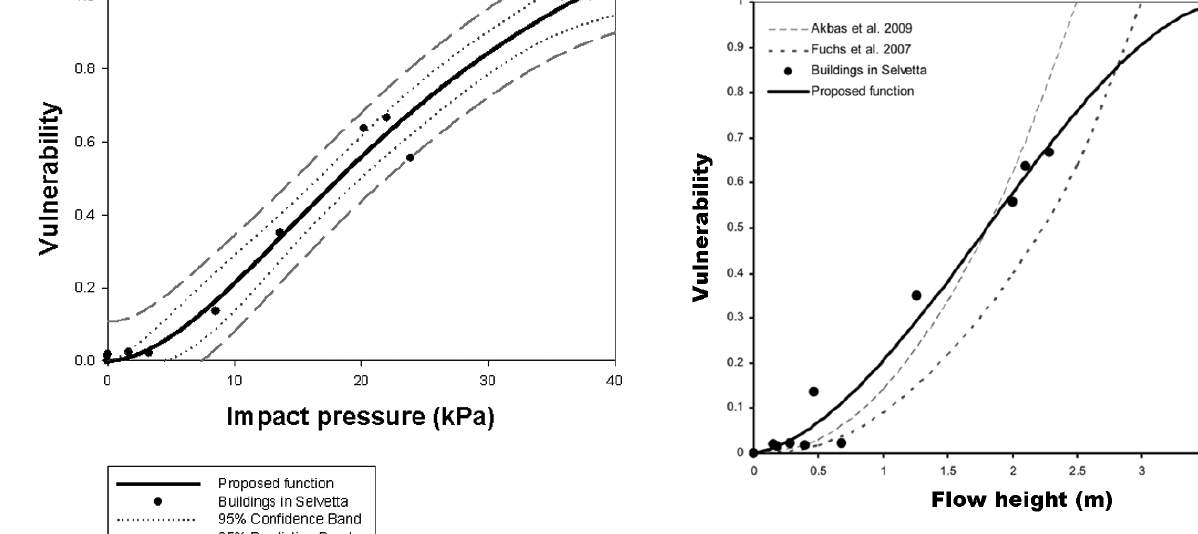
Fig. 11. Comparison of the proposed vulnerability functions pro- posed by Akbas et al. (2009), Fuchs et al. (2007) and the vulnera- bility curve calculated from the Selvetta debris flow event in